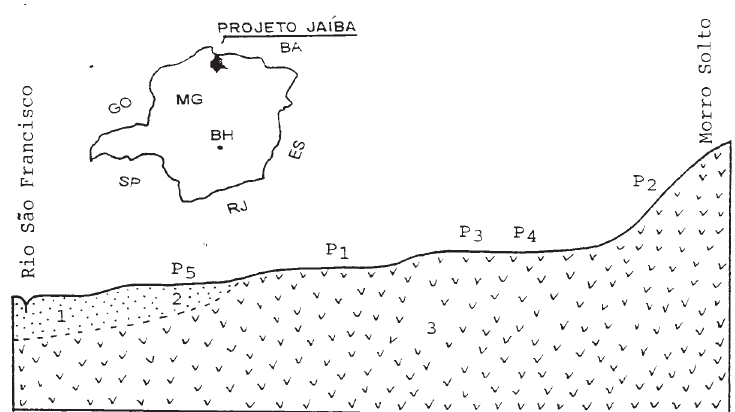
Figura 1. Mapa de localização da área e perfil esquemático, mostrando a localização de alguns dos perfil na paisagem. (1) sedimentos detríticos quaternários; (2) sedimentos detríticos terciários/quaternários; (3) rochas calcárias e pelíticas do Grupo